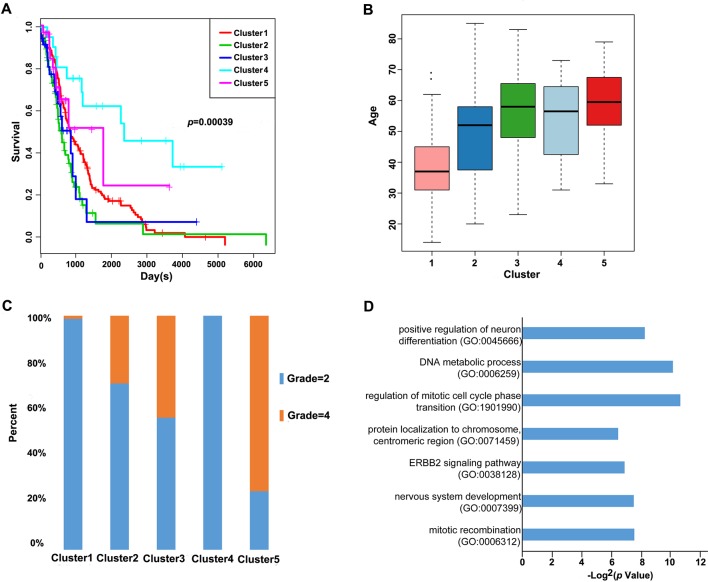
Prognosis, grade, age distribution, and survival of each sample in the molecular subtypes. (A) Survival curves of DNA methylation subtypes in the training set. The horizontal axis represents the survival time (days), and the vertical axis represents the probability of survival. The numbers in parentheses in the legend represent the number of samples in each cluster. The log-rank test was used to assess the statistical significance of the differences. (B) Age distributions of nine DNA methylation clusters in the training set. The horizontal axis represents the DNA methylation clustering. (C) Grade distributions of nine DNA methylation clusters in the training set. The horizontal axis represents the DNA methylation clustering. (D) The online network tool Enrichr was utilized for functional enrichment analysis of genes corresponding to the gene promoter regions annotated by the CpG sites that were significantly correlated with survival.